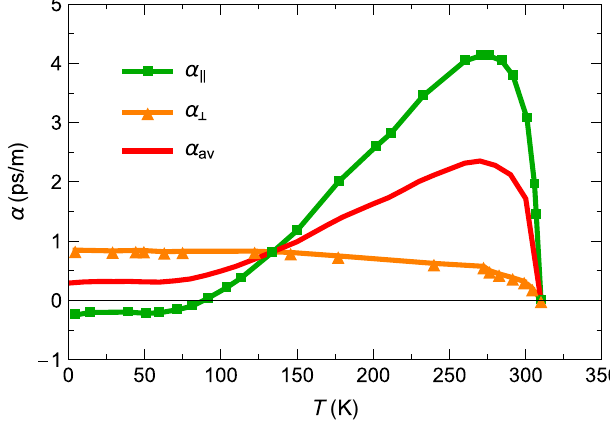
FIG. 4. Measured temperature dependence of the parallel ( α green squares) and perpendicular ( α ⊥ , orange triangles) mag- netoelectric response in Cr 2 O 3 . The red circles show the average, 1 α þ α ⊥ Þ . Data taken from Ref. 2 ð k